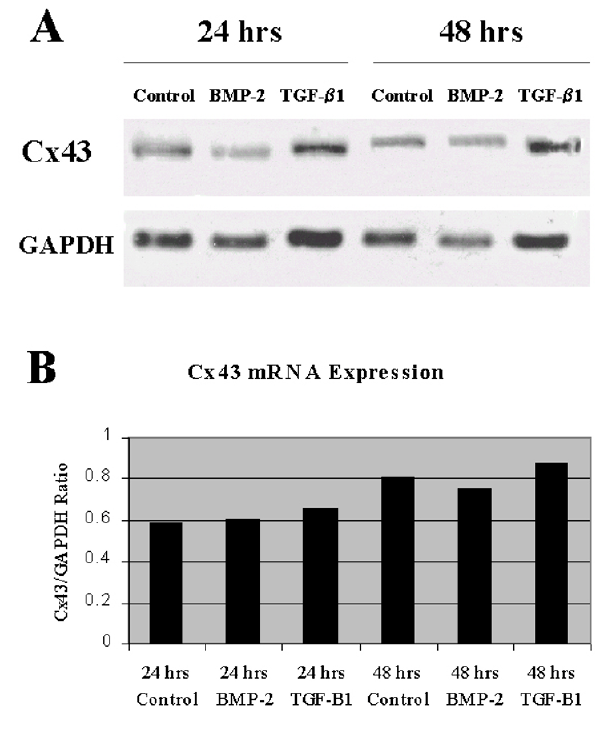
Figure 1 Effects of BMP-2 and TGF- β 1 on Cx43 mRNA expression. A. Northern blots demonstrating Cx43 expression for control, BMP-2, and TGF- β 1 groups after 24-h and 48-h treatments (top panel), with GAPDH control (bottom panel). B. Graphic representation of Cx43 mRNA expression normal- ized to